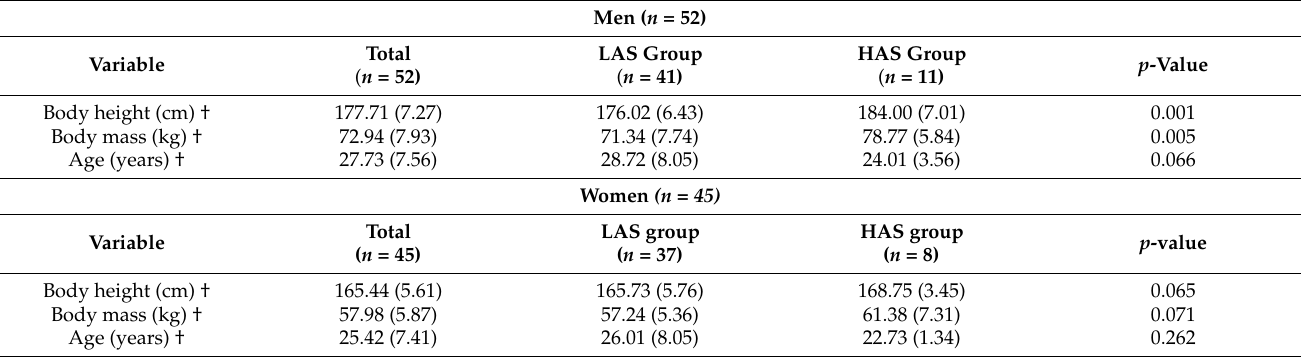
Table 2. Characteristics of participants according to the created subgroups (LAS vs. HAS groups), for both men and women.